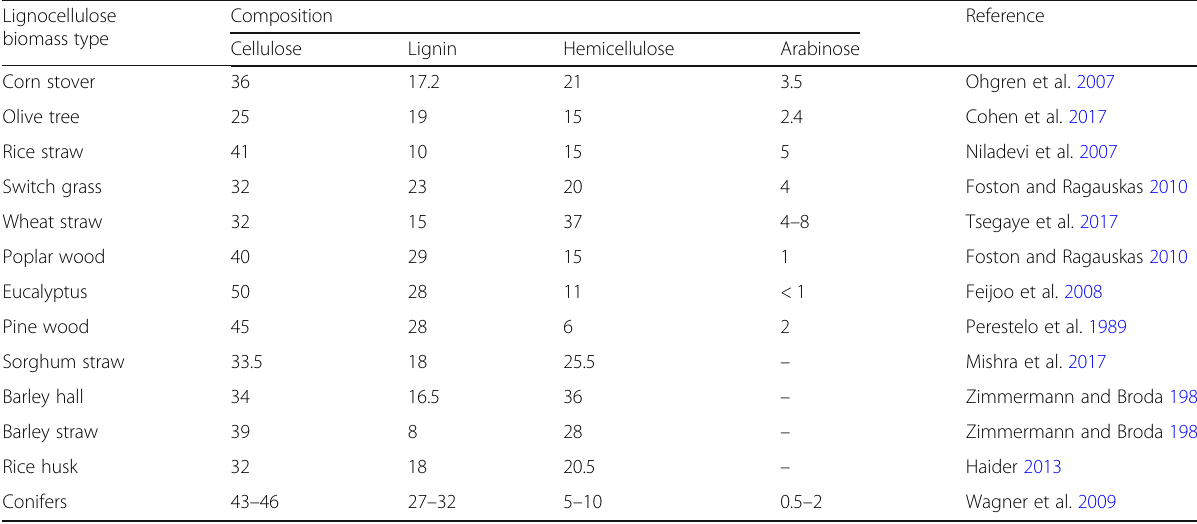
Table 1 Chemical compositions of various lignocellulose biomass (percentage in dry weight basis) Lignocellulose biomass